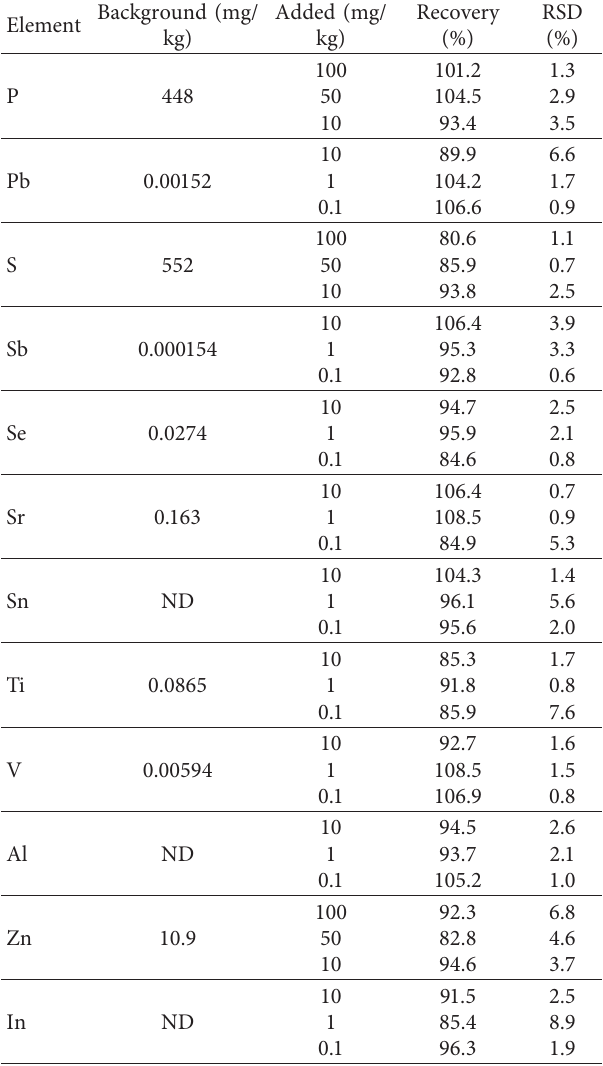
Table 6: The spike recovery and reproducibility of the spiked sample ( n �